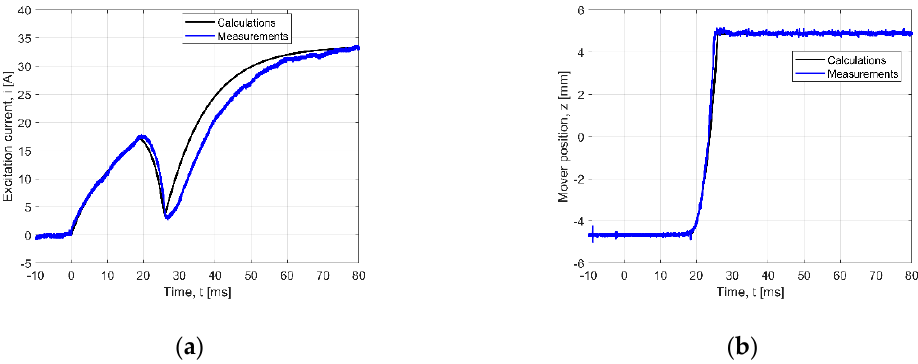
Figure 9. Verified transients for no-load state: ( a ) current wave, ( b ) position wave.